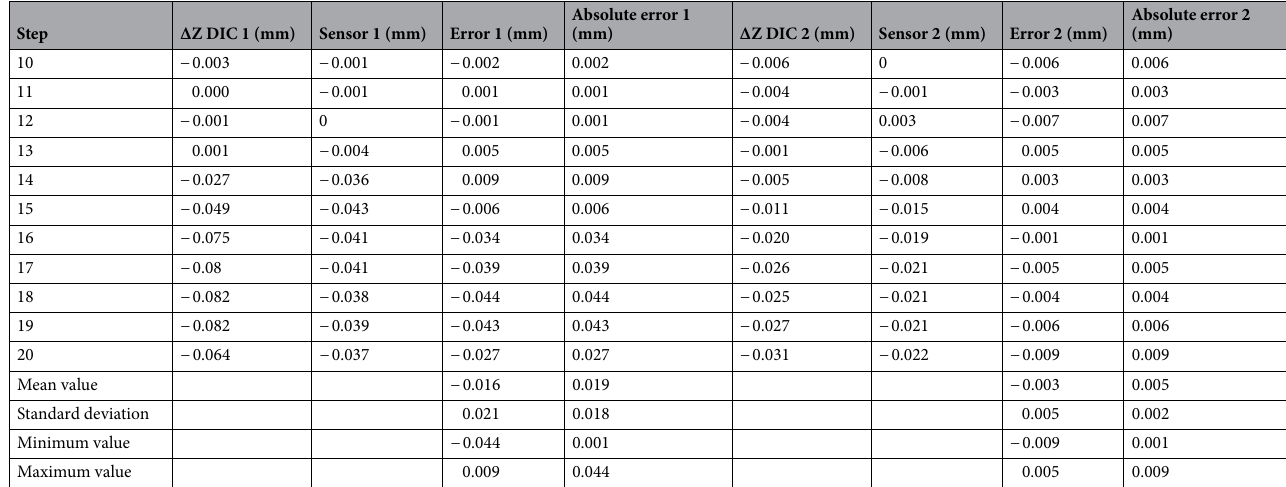
Table 1. Comparison of the deformation according to the sensors and the targets.